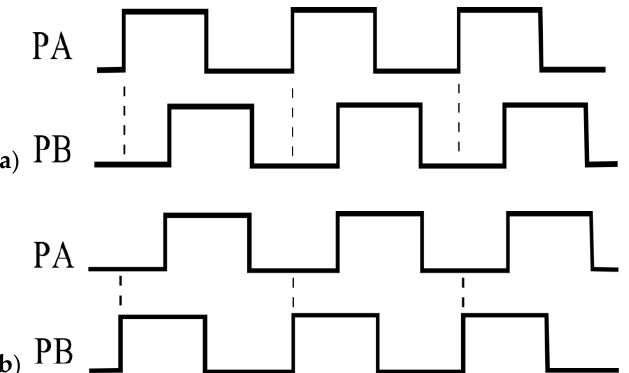
Figure 12. Pulse waveforms generated by the encoder: ( a ) forward motion; ( b ) backward motion.